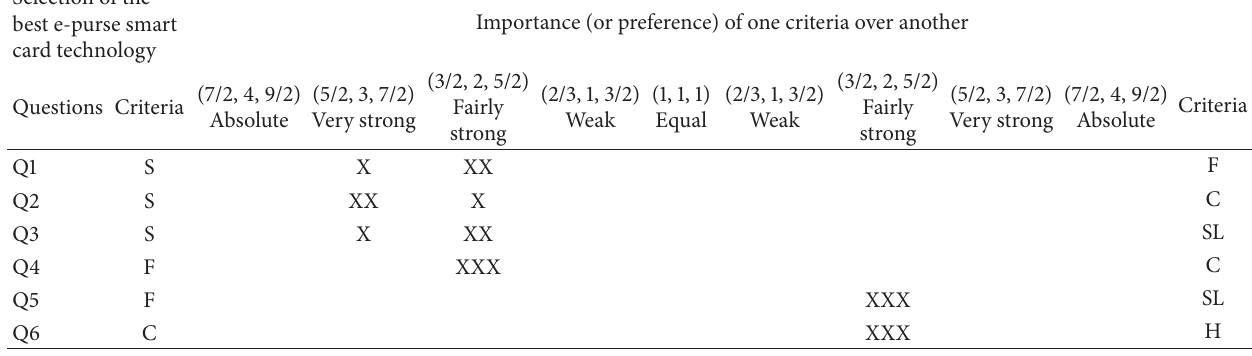
Table 3: A sample from the questionnaire.